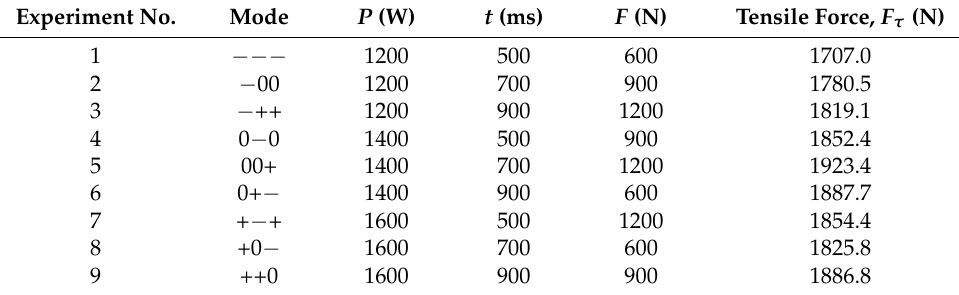
Table 2. Orthogonal table of the copper ultrasonic welding